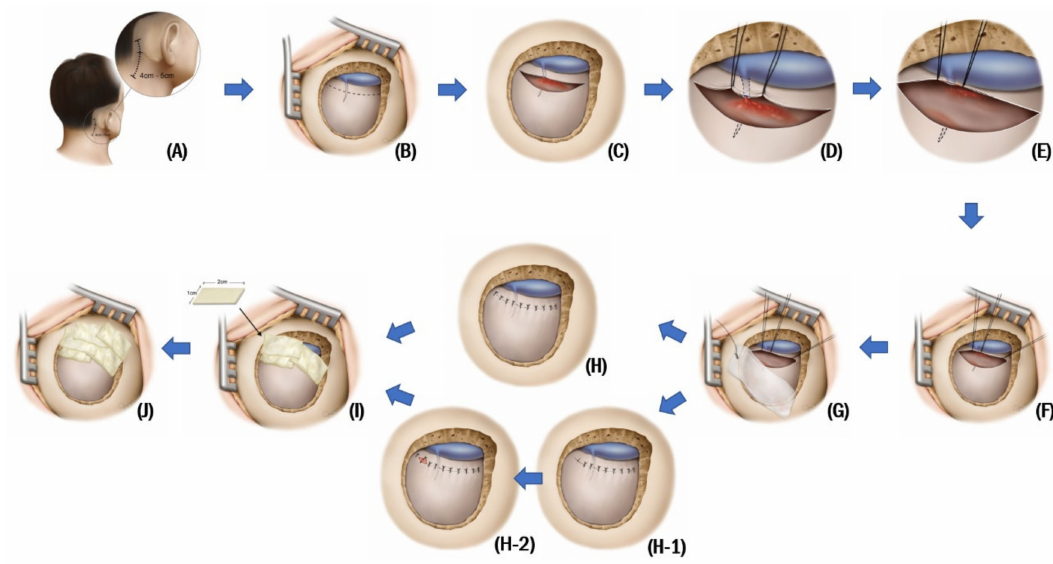
Figure 1. A 4- to 5-cm curvilinear skin incision was made along the hairline, and then retromastoid craniectomy was performed ( A , B ). A dural incision along the posterior margin of the sigmoid sinus was made approximately 2–3 mm away from the sinus margin for later dural repair ( C ). Upon bleeding from the cut dural veins, instead of electrocautery, one or two stay sutures were performed just around the cut vein. Thereafter, pulling these stay sutures tightly could easily cease bleeding from the cut veins ( D , E ). Stay sutures were performed along with the incised sinus-side dura mater as close as possible to the sinus margin and were pulled tightly to maximize visualization of an intracranial surgical corridor while minimizing cerebellar retraction ( F ). After completing the stay sutures, a wet cottonoid was placed on the cerebellar-side dura mater ( G ). During the closure, following the completion of the intradural procedures, primary dural closure was always attempted using interrupted sutures ( H ). If primary dural closure was not possible, a “plugging muscle” method, published elsewhere [5], was used ( H-1 , H-2 ). After dural closure, approximately 1 × 2 cm sized pieces of fibrinogen / thrombin-based collagen fleece (TachoComb ® ; Nycomed, Linz, Austria) were applied and overlapped in two or three layers on the dural incision site for additional sealing ( I ). After the bone edges of the mastoid air cells were thoroughly waxed, the bone edges were covered again using the remaining pieces of fibrinogen / thrombin-based collagen fleece ( J